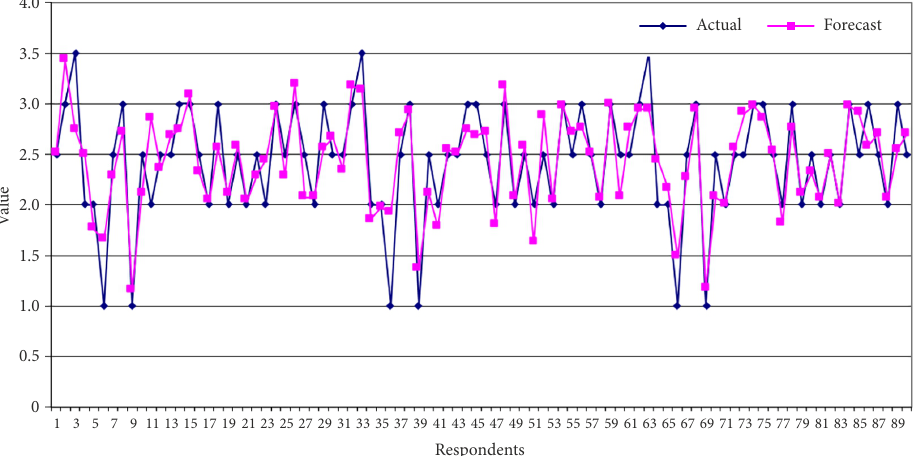
Figure 3. The values of the dependent variables assessed by experts and calculated by Model Y for MON (source: calculated by